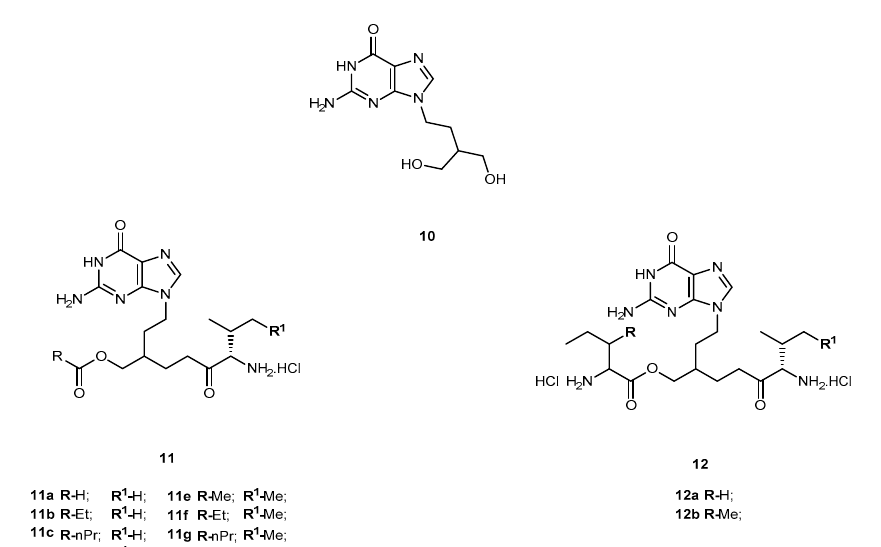
Figure 6. Structures of penciclovir ( 10 ) and its amino acid ester prodrugs 11 and 12 .